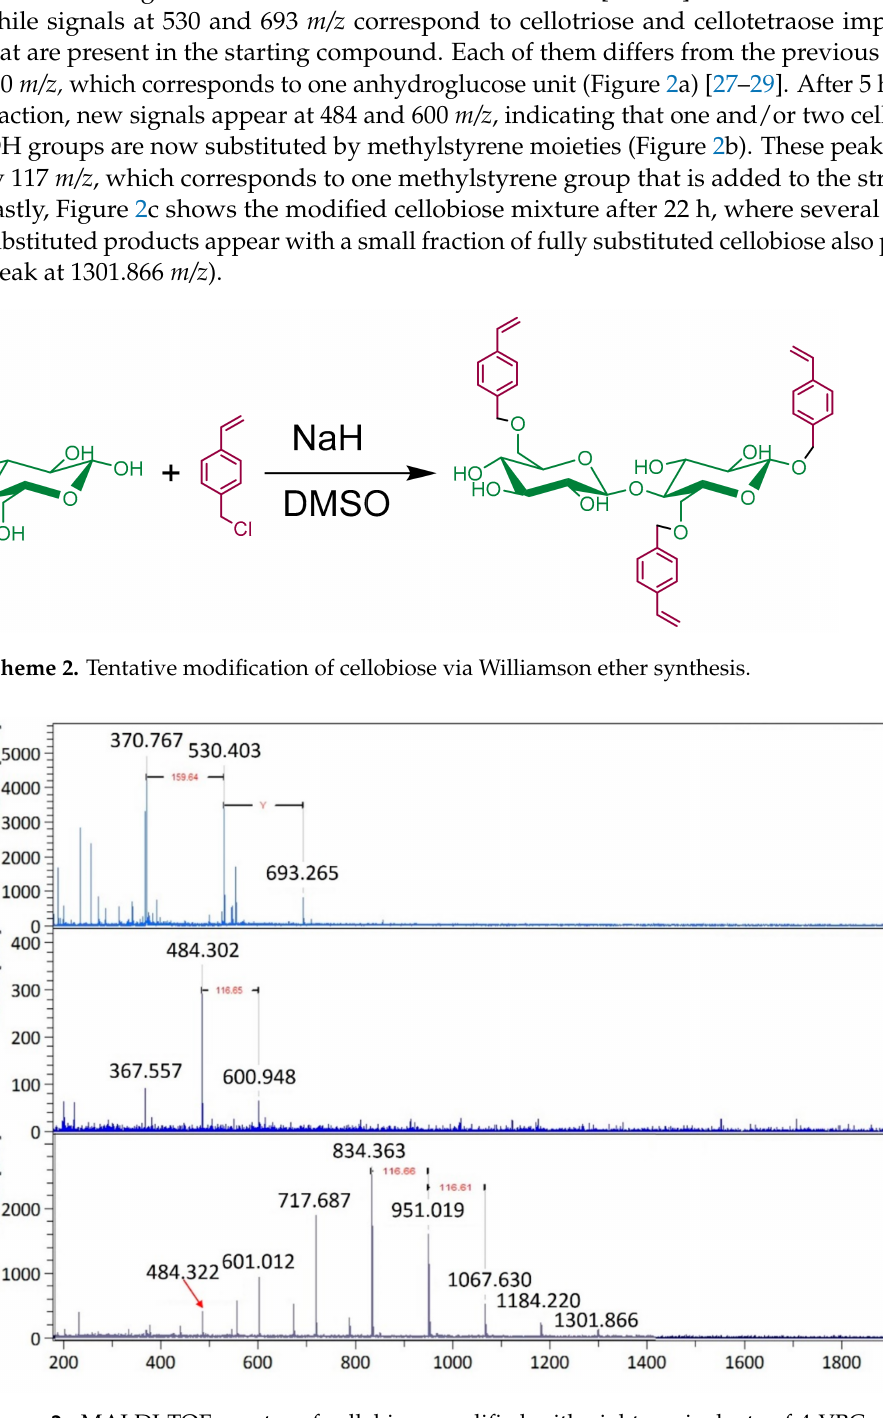
Figure 2. MALDI-TOF spectra of cellobiose modified with eight equivalents of 4-VBC at 25 ◦ C. ( a ) neat cellobiose; ( b ) modified cellobiose after 5 h; ( c ) modified cellobiose after 22 h. DHB was used as a